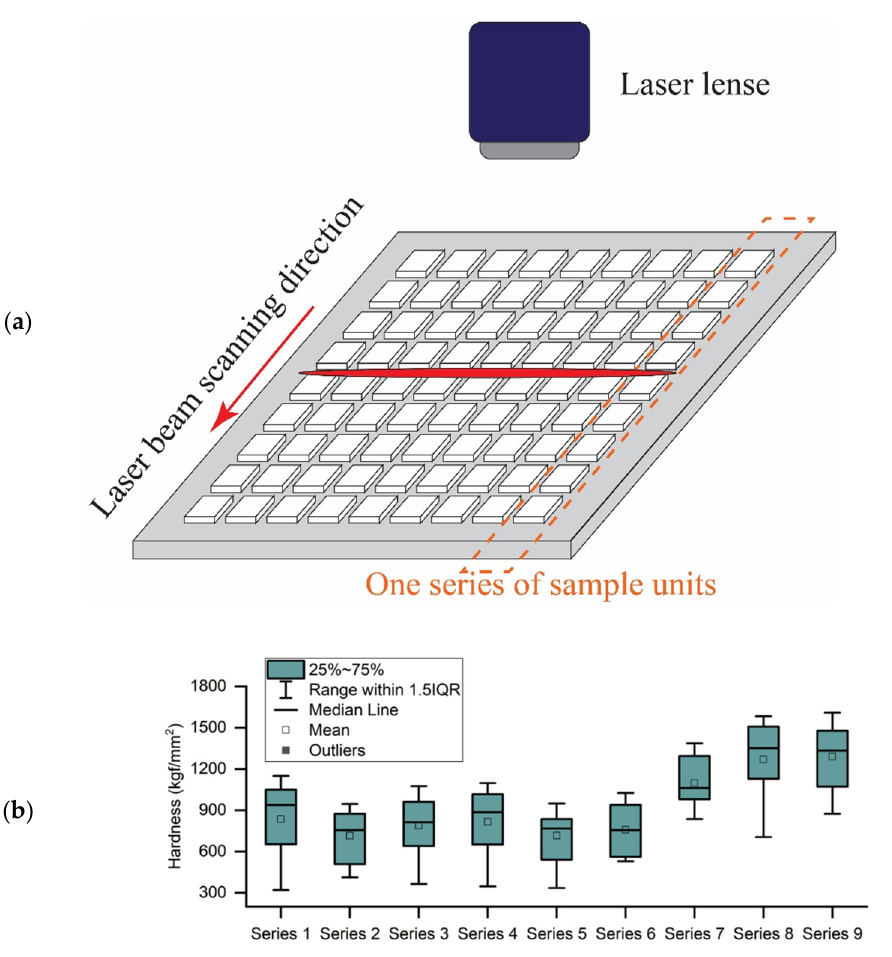
Figure 6. ( a ): Illustration of the laser sintering of an alumina sample array. ( b ): Hardness distributions of the sample